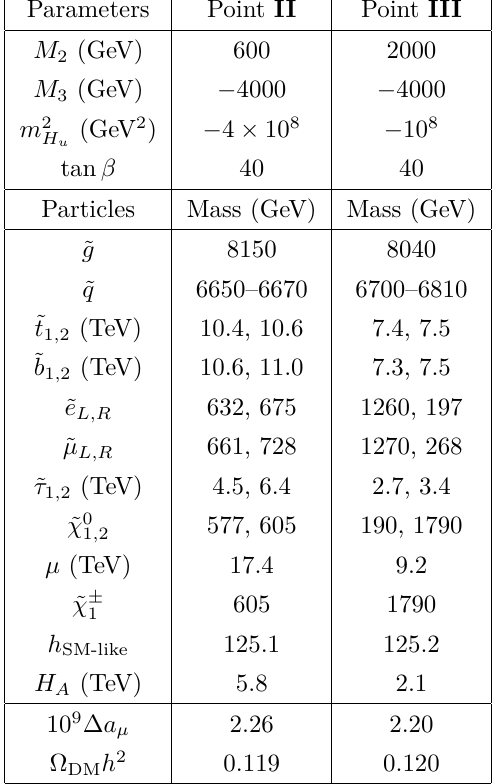
= M N = M N = 10 9 1 2 3